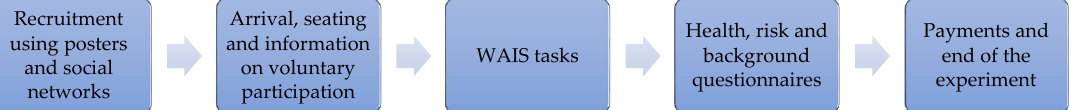
Figure 1. Experimental design.